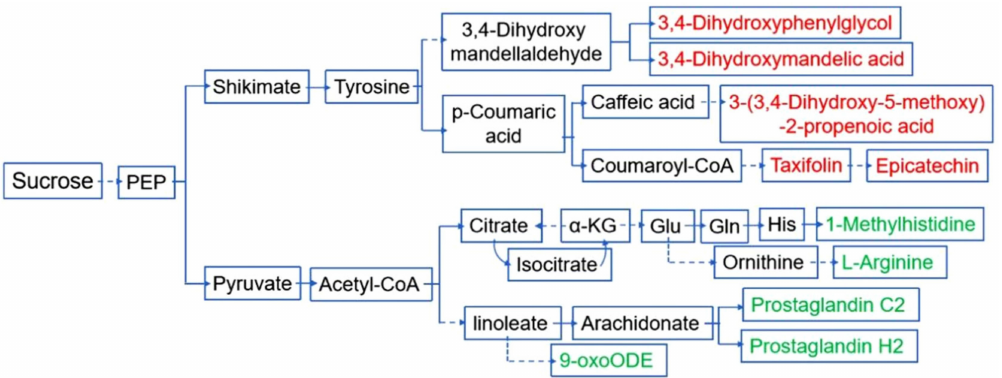
Figure 5. Integrated pathway of differential metabolites in L accessions. The red and green characters represent up- and down-regulated metabolites, respectively, in L accessions compared to H accessions. Solid lines represent direct reactions, dotted lines represent indirect